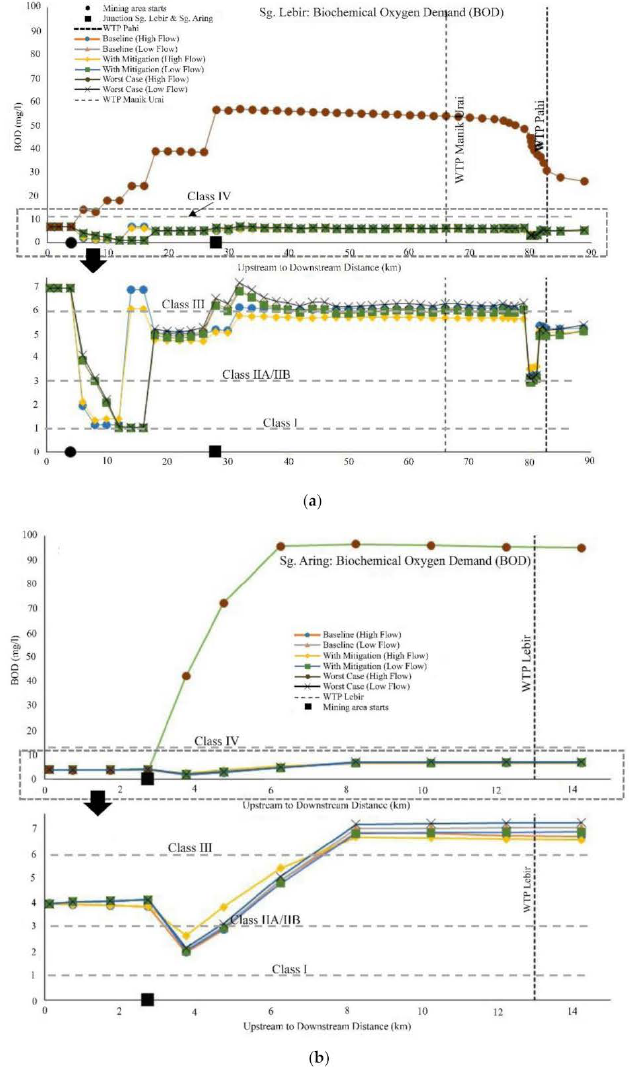
Figure 5. ( a , b ) showing BOD concentrations in different scenarios for Sungai Lebir and Sungai Aring,